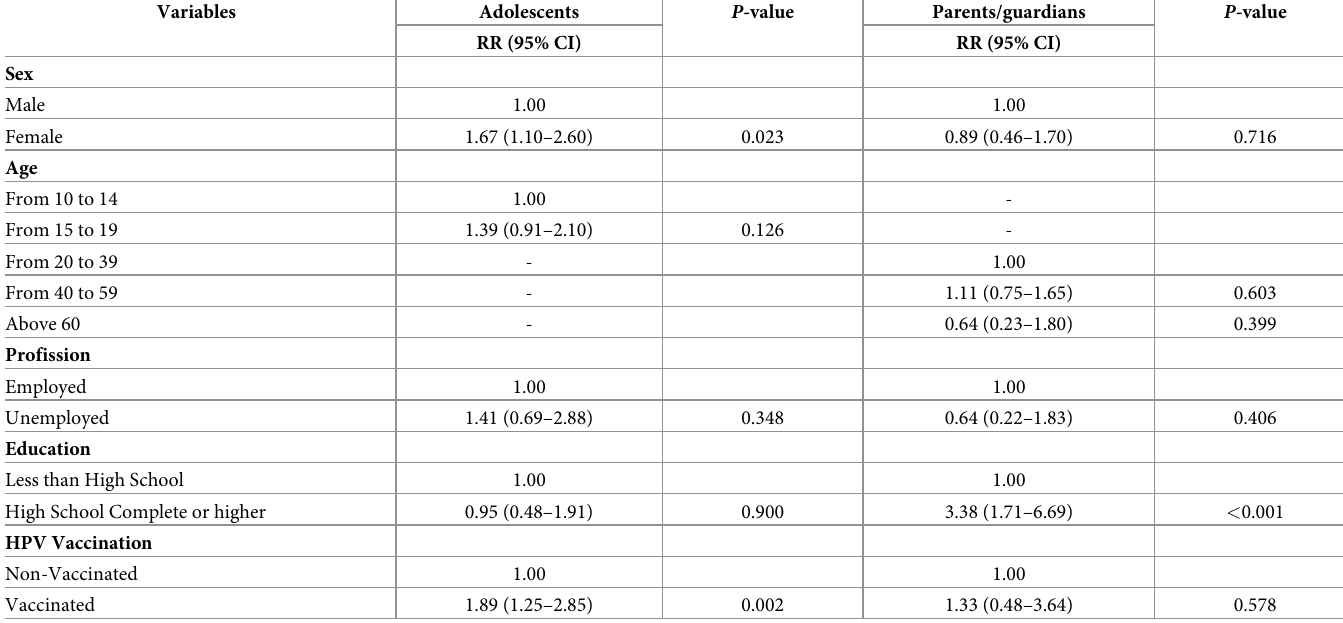
Table 3. Multivariable analysis of factors associated with knowledge about HPV, its clinical repercussions and its vaccine among parents/guardians and adolescents interviewed during implementation of HPV vaccine. Sao Paulo, Brazil,